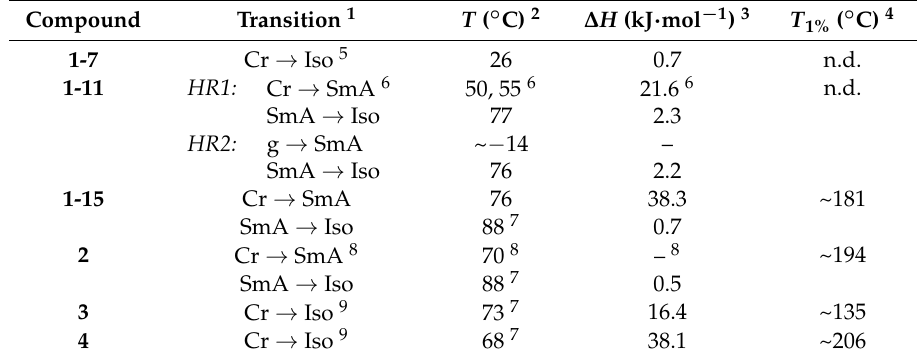
Table 1. Summary of phase transition temperatures and other thermal data recorded for